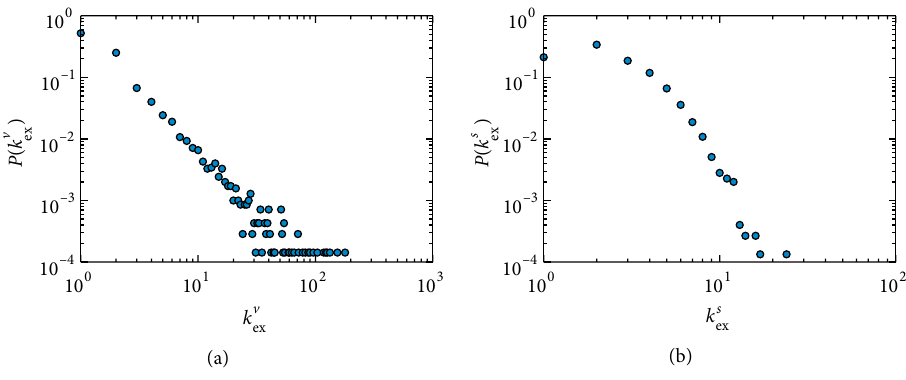
Figure 2: (a) External degree distribution of VC nodes ( 𝑁